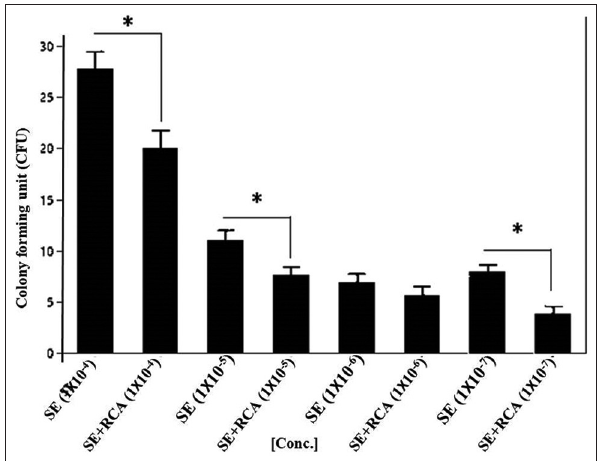
Figure-4: Salmonella Typhimurium (ST) on MacConkey agar. ST isolate in broth was 10-fold serially diluted and mixed with a constant concentration of anti- Salmonella DNA aptamers in the form of rolling circle amplification (RCA) products. The colony-forming unit (CFU) was calculated and blotted with a concentration of the RCA products. The CFU was significantly reduced (p<0.001) in the lower dilution 1×10 –4 .